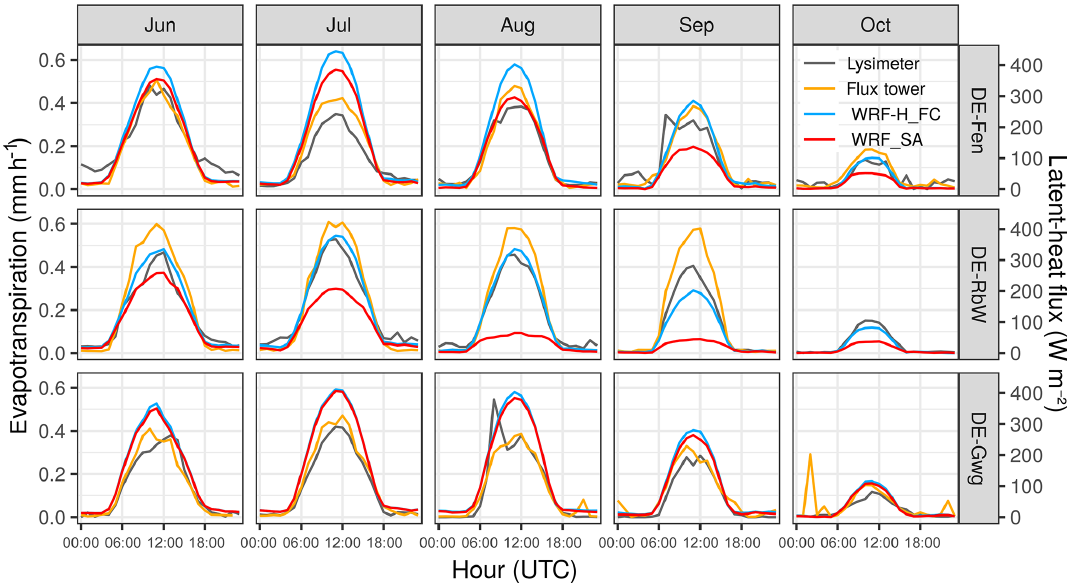
Figure 8. Mean diurnal cycles of simulated and observed latent-heat flux and evapotranspiration for the months June to October 2016 at different TERENO Pre-Alpine Observatory sites.